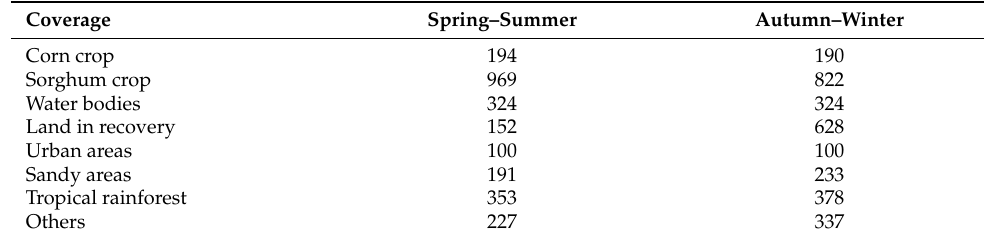
Figure 3. Sample points on the GEE platform. Table 3. Sample points